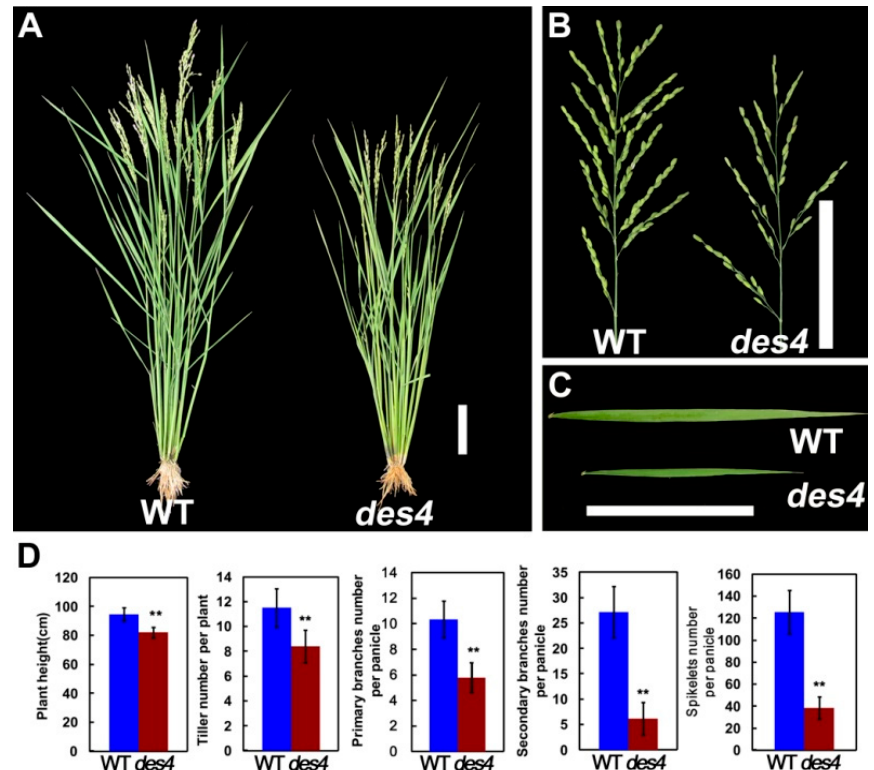
Figure 1. Phenotypical characterization of the des4 and wild type (WT). ( A ) Plant architecture, ( B ) panicle structure, and ( C ) leaf shape of des4 and WT, bar = 10 cm. ( D ) Quantification of the plant height, tiller number, primary branches, secondary branches, and spikelet numbers per panicle. Numerical values are expressed as the mean; error bars denote one standard deviation of the mean; asterisk denotes significant difference between mutant and WT within each treatment (** p < 0.01; Student’s t -test).